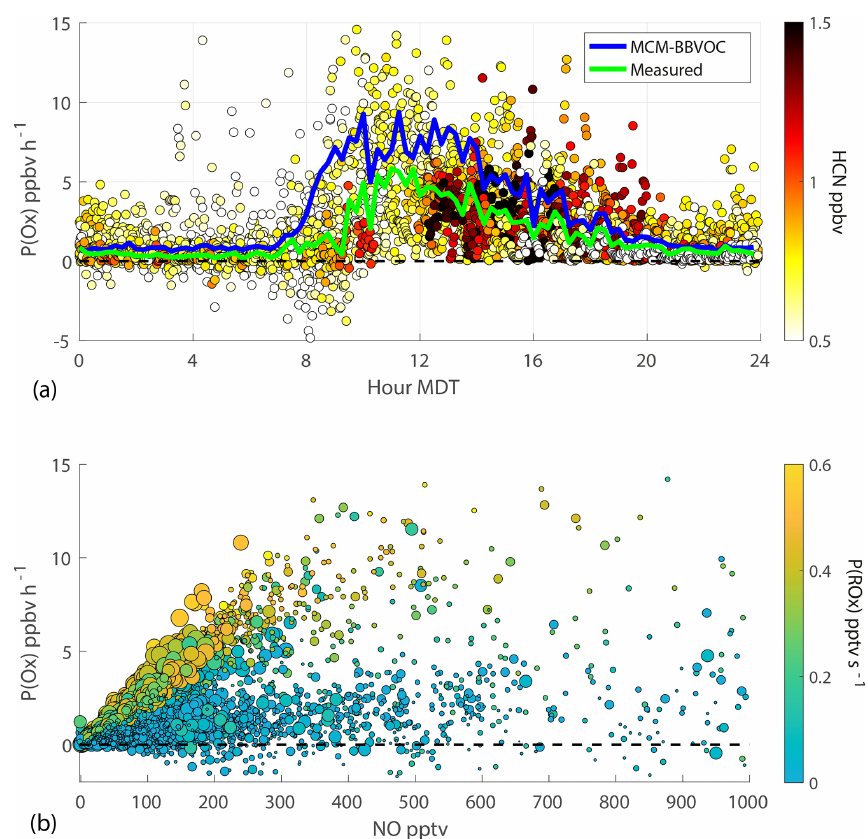
Figure 5. P (O x ) results derived from 2min XO 2 observations. Panel (a) shows the diurnal profile of all calculated P (O x ) values. The data points are colored by smoke tracer HCN. The green and blue traces represent 15min median values of P (O x ) as determined using measurements and model results, respectively. The provided model results were acquired with F0AM using the MCM-BBVOC mechanism. Panel (b) shows the variation of P (O x ) with NO. Data are colored by P (RO x ) and sized by